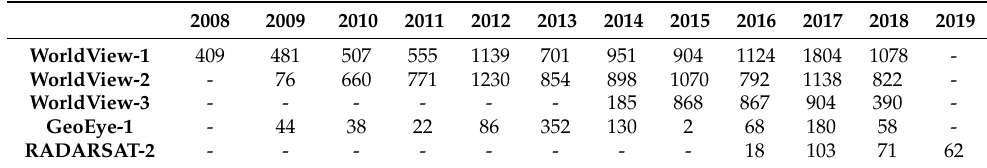
Table 1. Image acquisitions by sensor and